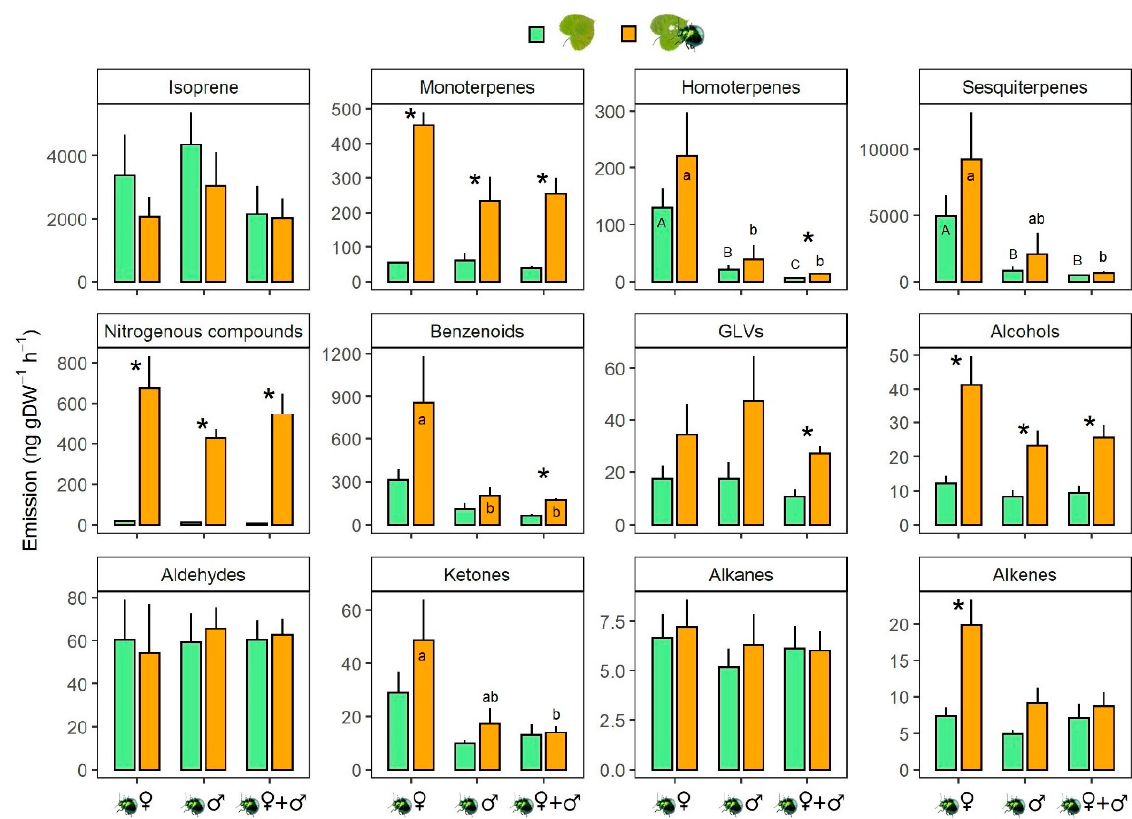
Figure 3. Emission of different groups of volatiles from hybrid aspen in response to leaf beetle attack. Seedlings were infested (orange bars) for approximately 48 hours by female adults of leaf beetle ( ♀ ), or male adults ( ♂ ), or a mixture of females and males ( ♀ + ♂ ), with their respective control left uninfested (green bars). Volatiles were collected following insect olfactory bioassays. Asterisks indicate significant differences between control and damaged plants within each gender ( p values < 0.05) after a paired T-test or Wilcoxon matched-pair signed-rank tests. Different upper- and lower-case letters indicate significant differences among genders within control and damage treatments, respectively, based on pairwise Wilcoxon–Mann–Whitney tests using Benjamini and Hochberg post-hoc correction following Kruskal–Wallis tests. Data represent mean ± SEM. n = 4 ( ♀ ), 5 ( ♂ ) and 6 ( ♀ + ♂ ). GLVs: green leaf volatiles. See Table S3 for breakdown of individual compounds within each compound class.